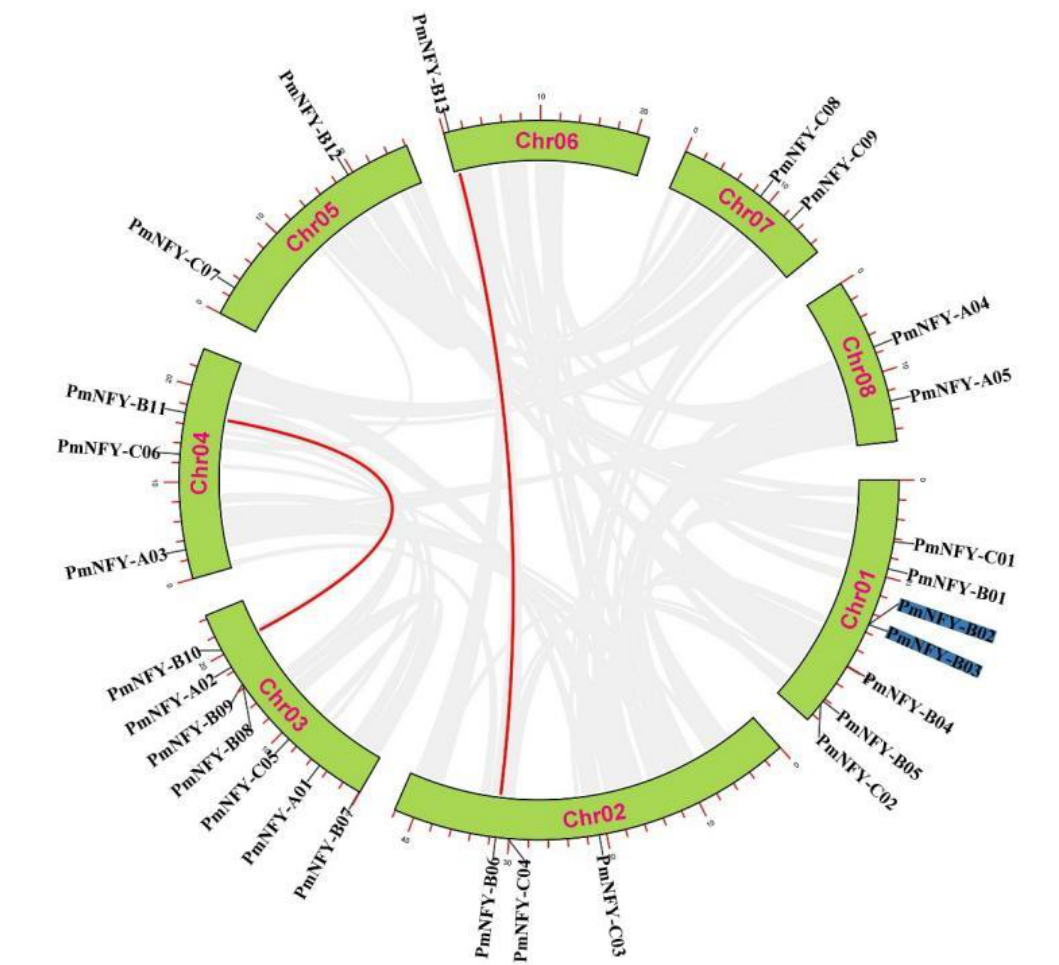
Figure 3. Synteny relationships of Prunus mume NF-Y genes. PmNF-Y gene duplication relationships. Genes that are tandemly repeated are labeled in blue, and genes that are segmentally duplicated are linked with red lines. Table 2. The Ka/Ks values of repeated PmNF-Y gene sequences.